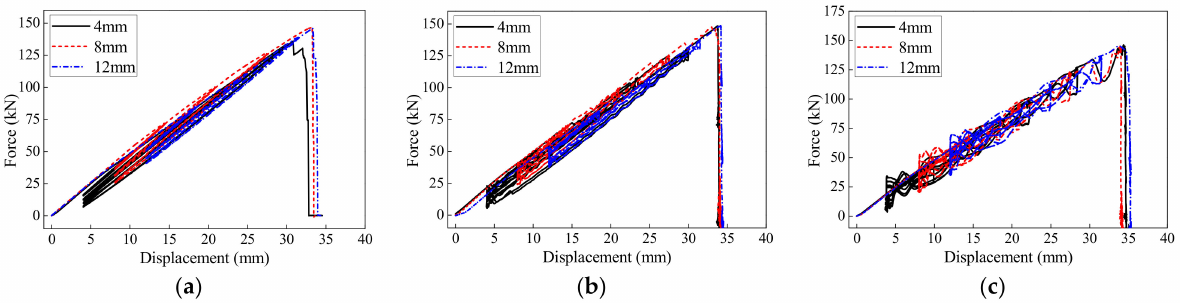
Figure 12. Hysteretic displacement-force curves of the BFRP tendons under different prestressed displacement: ( a ) 0.1 mm/s; ( b ) 50 mm/s; ( c ) 200